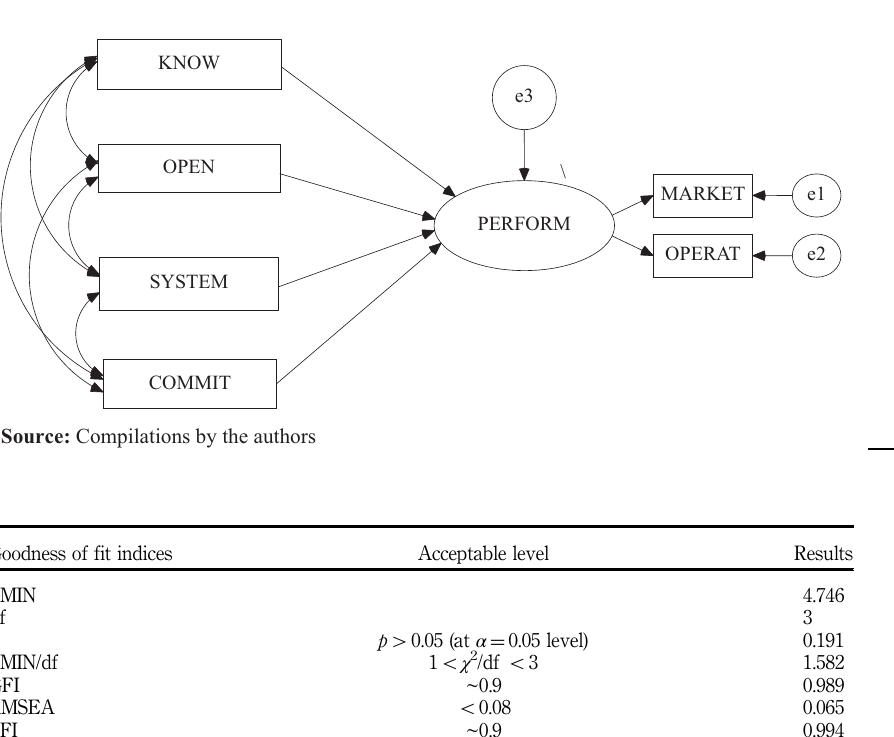
Table II. Model fit summary